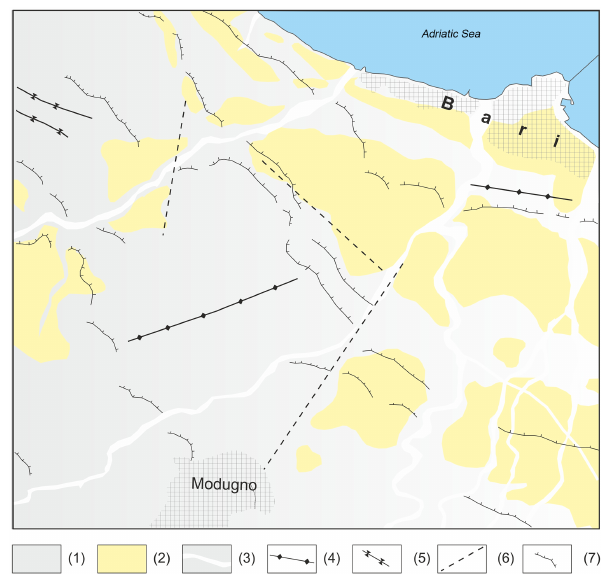
Figure 1. Simplified geological map of the area of Bari: (1) Calcare di Bari formation (Cretaceous); (2) Calcareniti di Gravina formation (Lower Pleistocene); (3) hydrographic network; (4) anticlinal axis; (5) syncline axis; (6) fault (uncertain); (7):